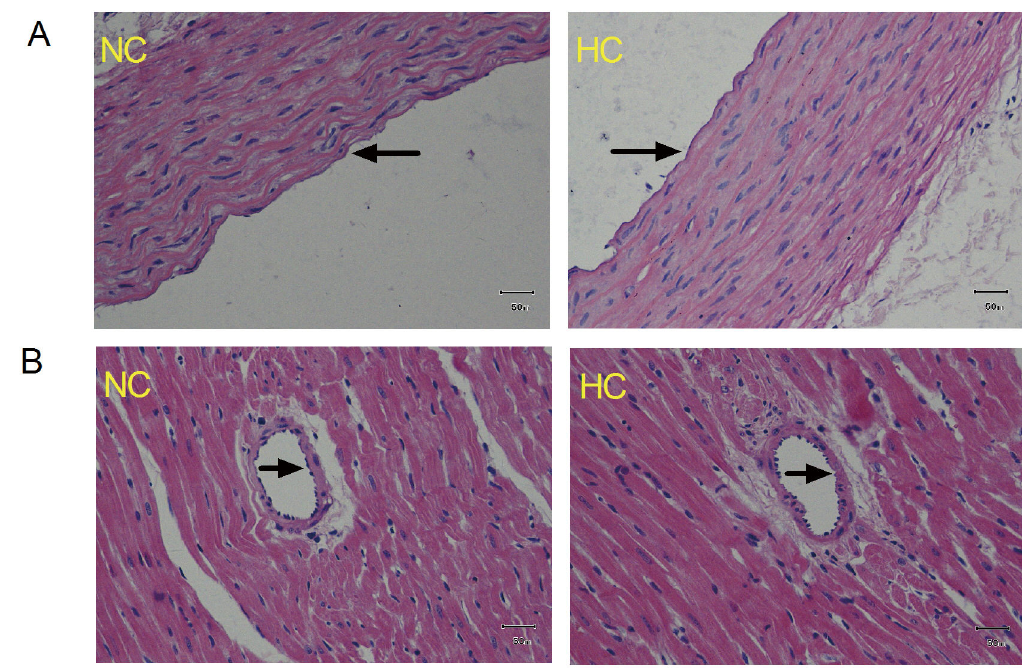
Figure 1. Representative cross-sections of the thoracic aorta (A) and the left myocardial branch of the coronary artery (B) from normocholesterolemic (NC) and hypercholesterolemic (HC) rats (fed 2% cholesterol-enriched chow for 8 weeks) by hematoxylin-eosin (HE) staining (400×). The arterial lumen is indicated by the arrow, n = 5 hearts/group.